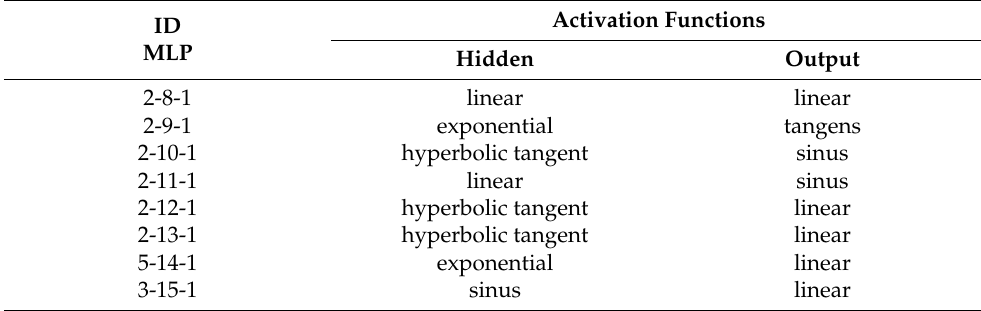
Table 3. Activation function for chosen MLP